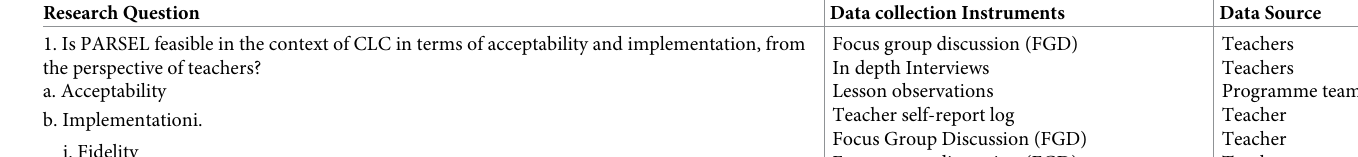
Table 1. Methods, data collection instruments and data source according to research questions. Research